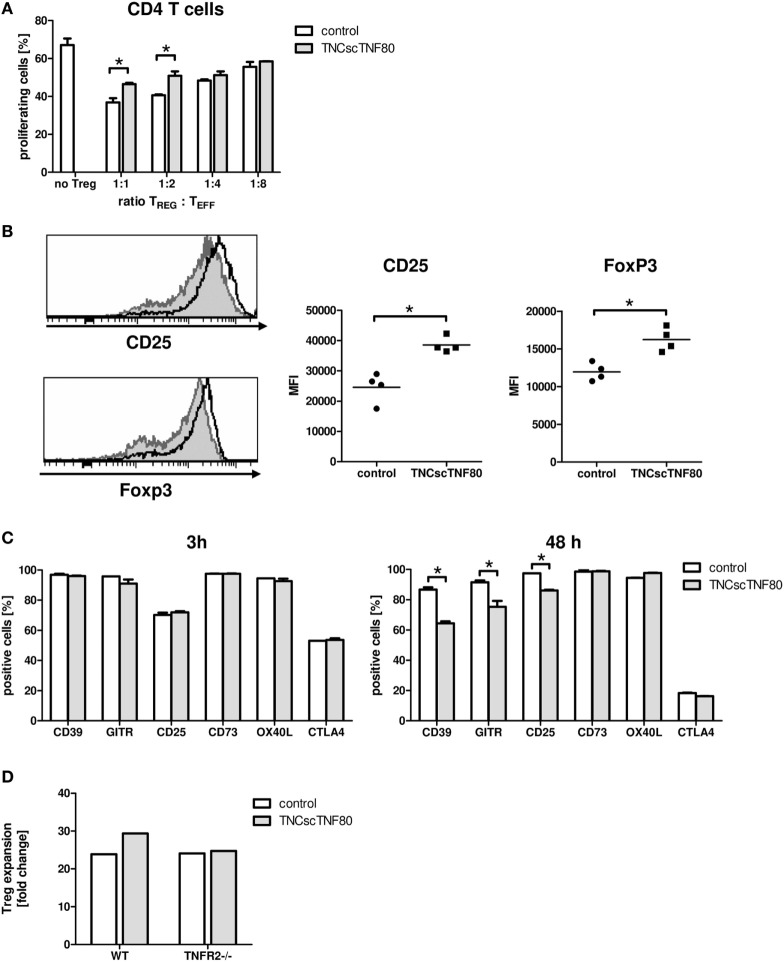
Effects of TNCscTNF80 on Treg cells. Treg cells from wild-type (CD45.1) mice were cultured with anti-CD3 activated TNFR2-deficient splenocytes (CD45.2) with or without TNCscTNF80 (10 ng/ml) at the indicated ratios. The percentage of proliferating CD4 T effector cells (CD45.2) was determined by flow cytometry after 72 h. Data are given as mean of culture replicates + SD from one out of two independent experiments (A). Treg cells from four CD45.2 mice were separately cultured with activated CD45.1 splenocytes with or without TNCscTNF80 (10 ng/ml). After 72 h, the expression profile (left) and the mean of the fluorescent intensity (MFI, right) for CD25 and Foxp3 of Treg cells (CD45.2) from these cultures were analyzed. The left panels show the marker expression profile of CD45.2 Treg cells in one representative culture without (gray histograms) and one culture with (black line histograms) TNCscTNF80. In the right panels, each symbol represents one mouse. Data from one out of four independent experiments are shown (B). Activated total splenocytes were cultured for 3 or 48 h with (gray bars) or without (white bars) TNCscTNF80 (10 ng/ml), and the expression of the surface markers CD39, GITR, CD25, CD73, OX40L, and CTLA-4 were determined on Treg cells (CD4+Foxp3+) by flow cytometry. Data from one experiment are given as mean of culture replicates + SD (C). Purified CD4+CD25highCD62L+ Treg cells from wild-type as well as TNFR2-deficient (TNFR2−/−) mice were cultured in the presence of antibodies to anti-CD3ε, anti-CD28, and recombinant human IL-2 with or without TNCscTNF80. After 7 days, the cell yield of Treg (CD4+Foxp3+) cells from wild-type and TNFR2-deficient mice was determined, and the expansion calculated. Representative data of one experiment out of two with similar results are shown (D).